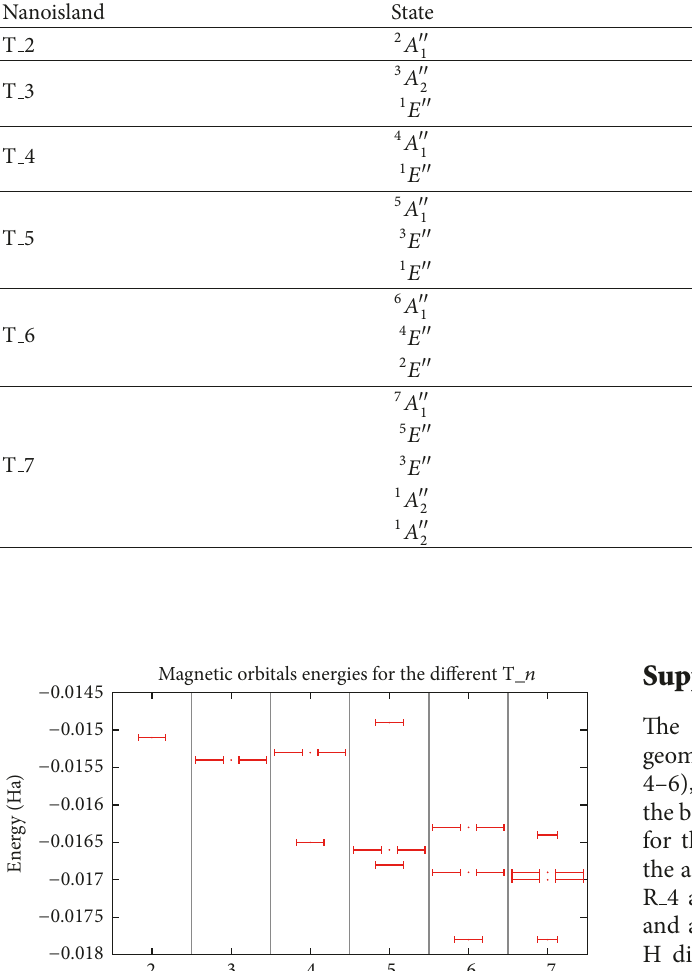
Table 3: C=C and C-H distances and angles in hexagonal nanoislands, Part 3. Table 4: C=C and C-H distances and angles in rhombus nanoislands. Table 5: C=C and C-H distances and angles in rhombus nanoislands, Part 2. Table 6: C=C and C-H distances and angles in rhombus nanoislands, Part 3. Table 7: C=C and C-H distances and angles in triangle nanoislands. Table 8: C=C and C-H distances and